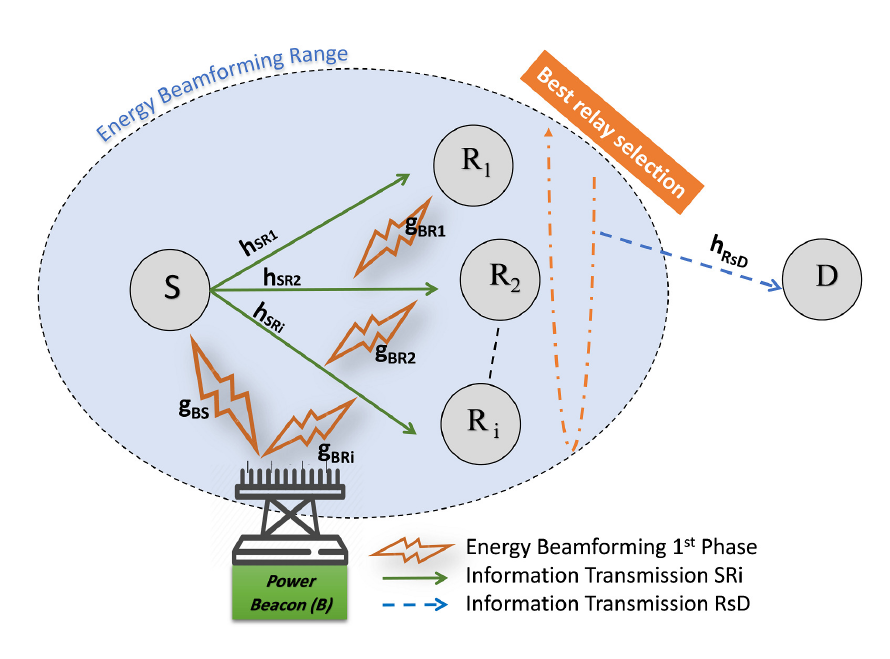
Figure 1. Multiantennas Power beacon-assisted wireless-powered cooperative communication network (PB-WPCCN) with energy beamforming and cooperative information transmission.